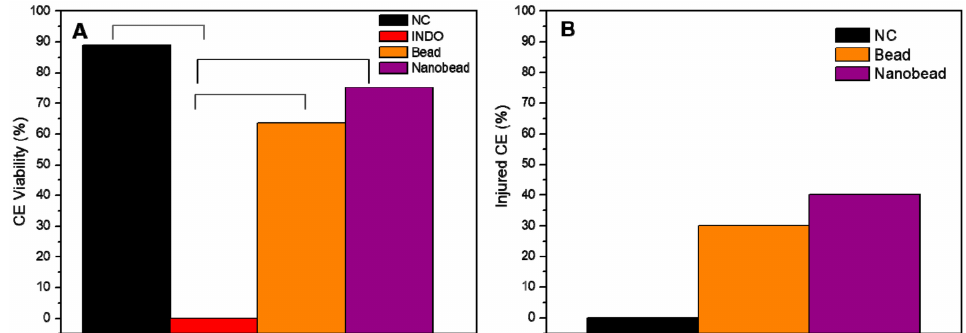
Figure 9. In vivo toxicity test through CE model in terms of embryos viability ( A ) and injured CE ( B ) after treatments with 0.9% NaCl solution (NC), indomethacin solution (20 mg/egg) as INDO, xanthan-coated chitosan bead loading indomethacin (bead) (XAN@CHT/INDO; 20 mg/egg) and xanthan-coated nanobead (nanobead) (XAN@CHT/NLC-INDO; 20 mg/egg). The Chi-square test, followed by binomial test between two proportions, was performed to compare INDO ( A ) or NC ( B ) with the bead or nanobead, considering their respective contingency tables (2 × 2). Statistically significant differences ( p < 0.05) are shown in ( A ), n = 12. ( B ) shows descriptive results.